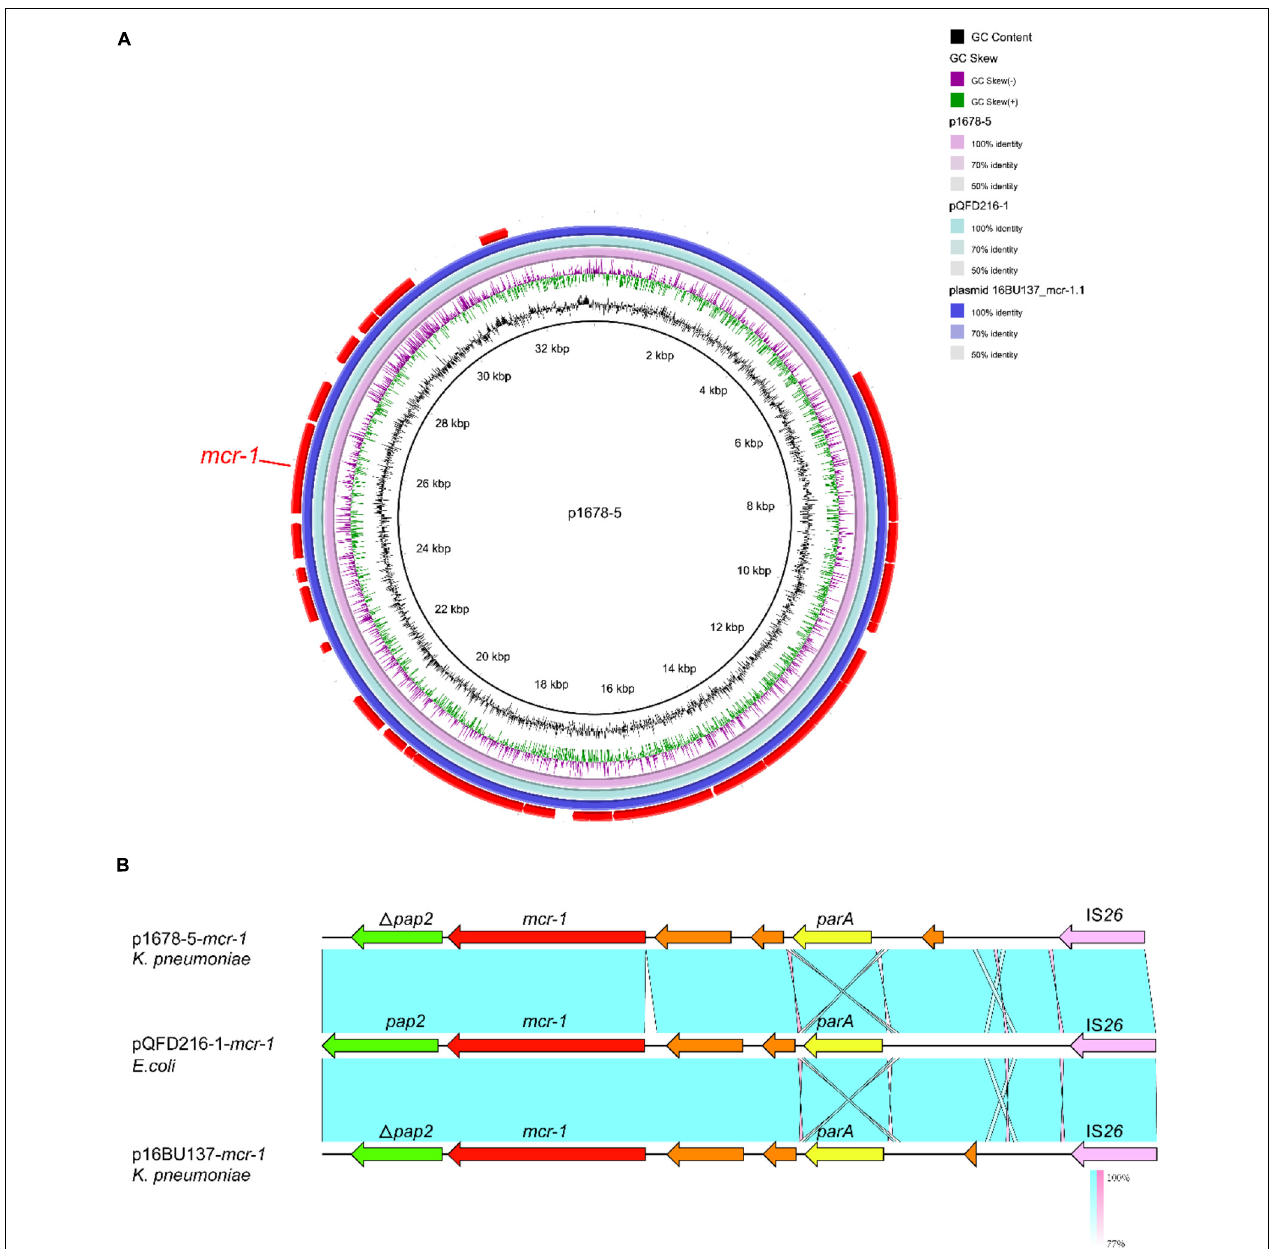
FIGURE 5 | Comparative analysis of pl687-5 plasmids with other reference plasmids. (A) p1678-5 (CP080449) was used as the reference plasmid to perform genome alignment with pQDFD216-1 (CP053212.1, E. coli ) and plasmid 16BU137 (MT316509.1, K. pneumoniae ). The red arrows represent CDs. (B) Linear comparison of the mcr-1 region. The mcr-1 region was compared with the mcr-1 regions extracted from pQDFD216-1 and